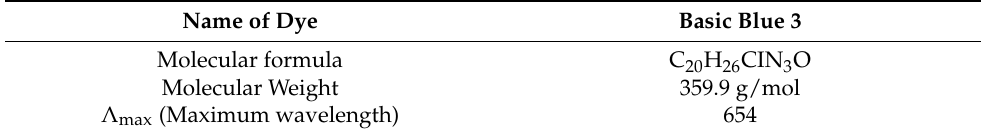
Figure 1. Structure of basic blue 3. Table 1. Physiochemical properties of basic blue